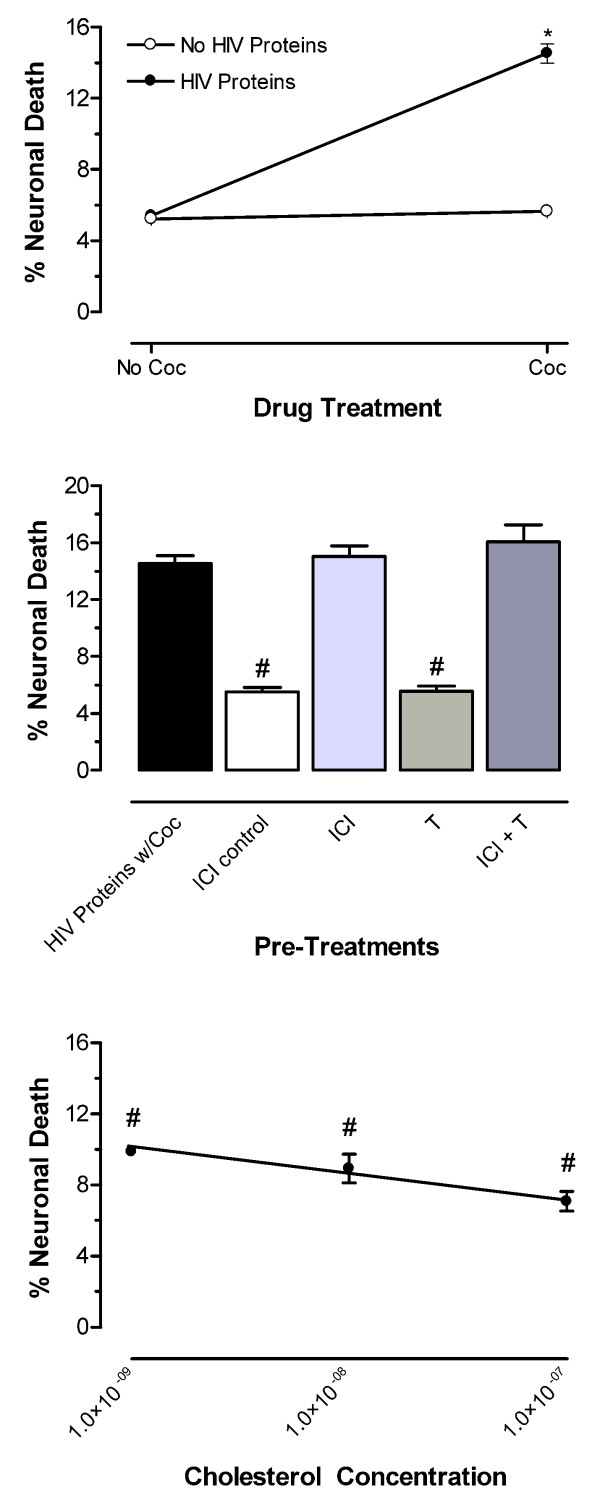
ER mediation of T's protection against synergistic neurotoxicity of HIV proteins with cocaine (Coc); cholesterol's [M] neuroprotection is incomplete. Control conditions of incubation with Locke's Buffer vehicle or the HIV proteins or Coc only produced similar neuronal death. (Top Panel) Significant interaction of the HIV proteins with Coc, as illustrated by the lines diverging from parallel, produces toxic synergism (*p < 0.0001. (Middle Panel) The ER specific antagonist, ICI-182,780 (ICI), completely blocked T-mediated neuroprotection. ICI's toxicity and T's neuroprotection did not differ from vehicle control (#p < 0.0001). (Bottom Panel) Cholesterol produced significant, concentration-dependent protection against synergistic neurotoxicity of HIV proteins w/ Coc (#p < 0.0001); however full protection was demonstrated only at 100 nM.